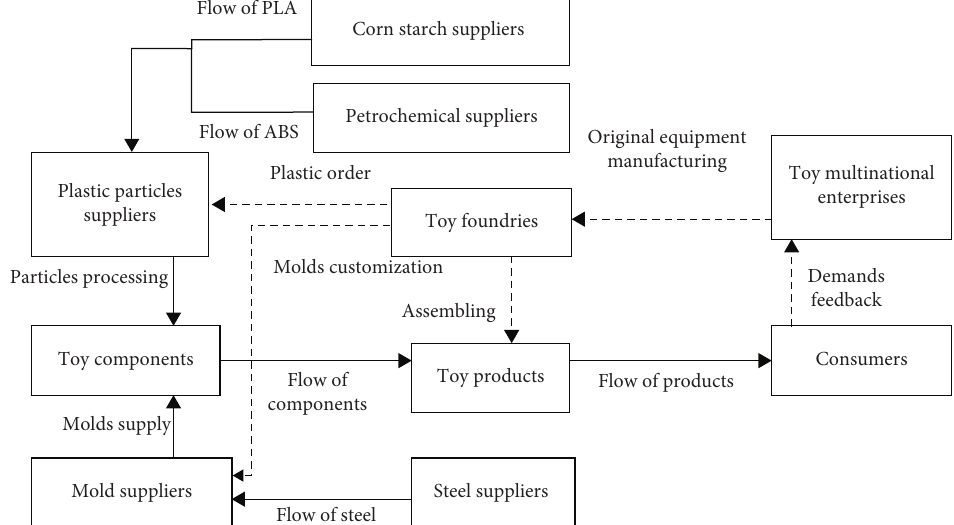
Figure 3: Chinese foundries mass manufacture toys through injection molding. Data source: figure, the solid line indicates the physical flows, and the dotted line indicates the nonphysical flows. The physical flows include raw materials, molds, and finished-products. Among these, the raw materials include two common plastics, acrylonitrile bu- tadiene styrene (ABS) or polylactic acid (PLA). ABS is a petrochemical and PLA is a bioplastic. The molds are made of steel. The nonphysical flows include information exchange among consumers, channels, and suppliers.